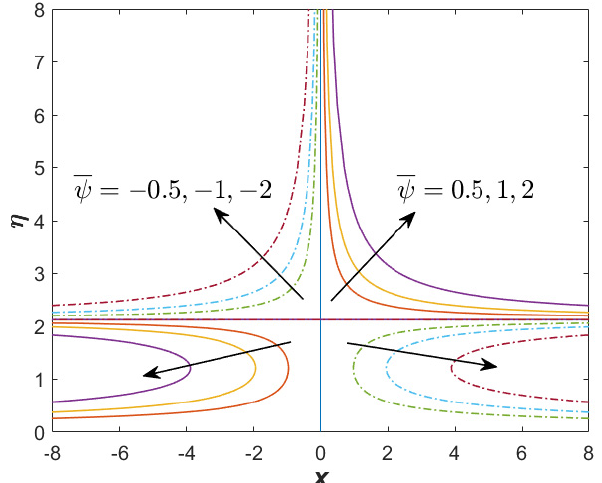
Figure 8. Streamline for the unique solution when α = 1.1, β = − 3 (unsteady accelerating flow), M = 0.25, Q = 0.1, and φ hf f = 0.02.